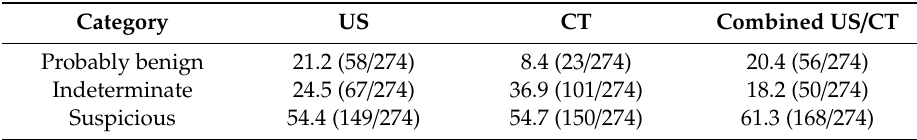
Table 1. Incidences of the US, CT, and combined US / CT